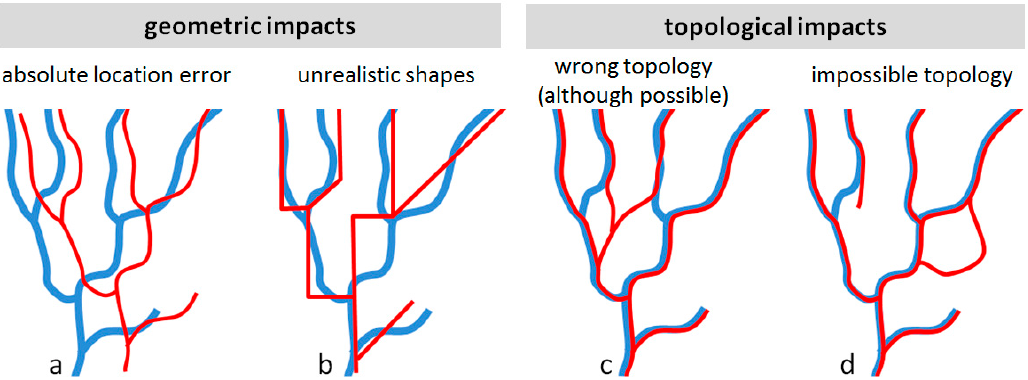
Figure 13. Main types of errors in the drainage network extracted from a DEM (blue line: real network; red line: network extracted from the DEM).